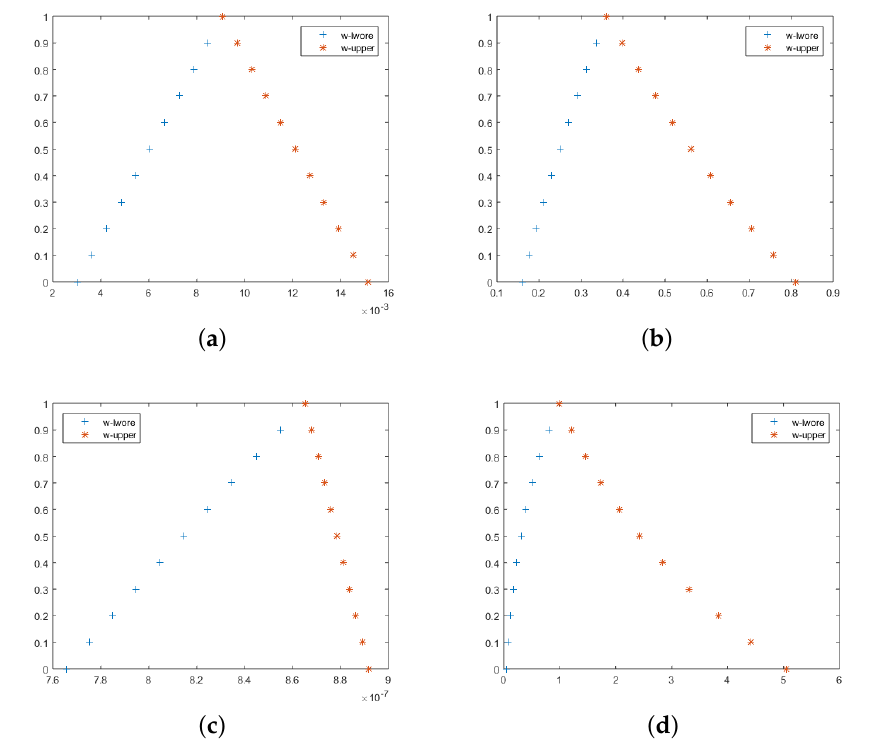
Figure 2. The exact lower and upper solutions of Equations (90), (100), (110), and (118) at ( a ) Λ = 0.0001, ϕ = 0.2, t = 2, ı = 1, ( b ) Λ = 0.002, ϕ = 0.1, φ = 0.6, t = 3, ı = 2, ( c ) Λ = 0.01, ϕ = 0.03, t = 7, ı = 3, and ( d ) Λ = 0.4, ϕ = 0.3, φ = 0.8, t = 4, ı = 4,